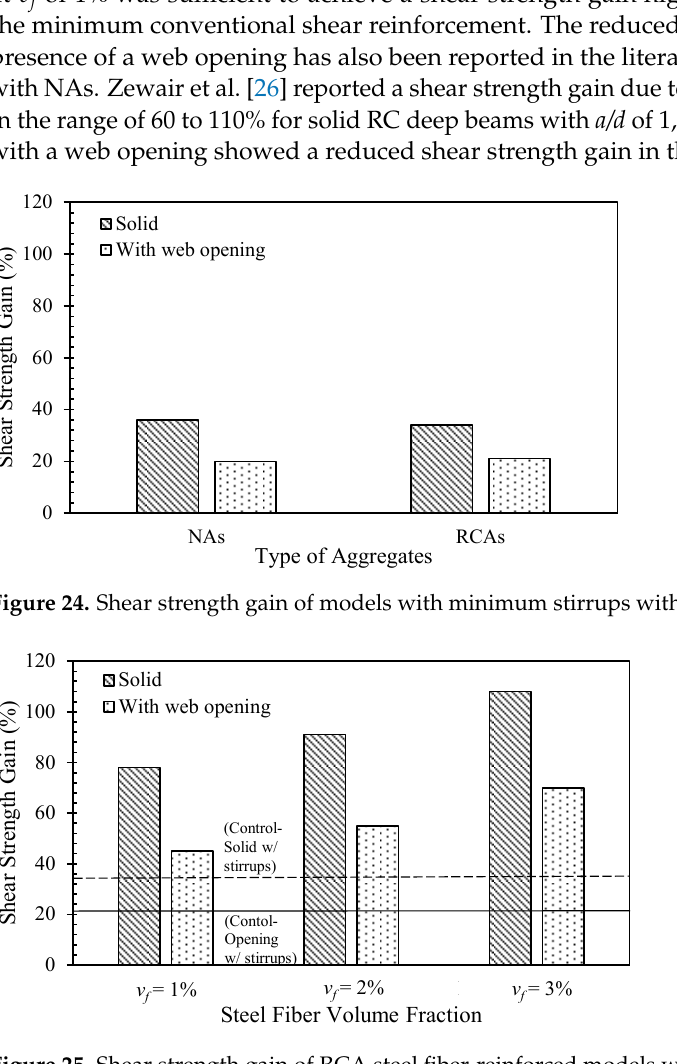
Figure 25. Shear strength gain of RCA steel fiber-reinforced models with and without openings.